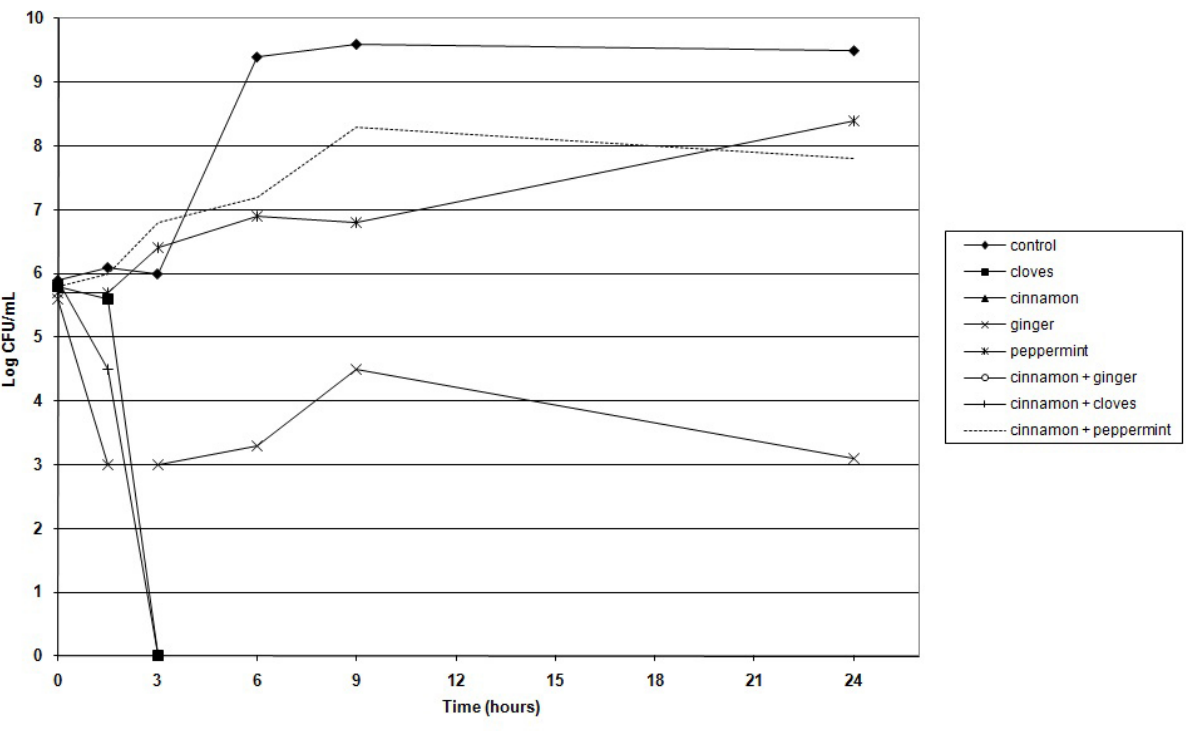
Figure 4. Log CFU x mL–1 values in the time kill curve of MIC90% values of the products separately and in combination with one quarter of MIC90% values for cinnamon oil with essential oils against E. coli